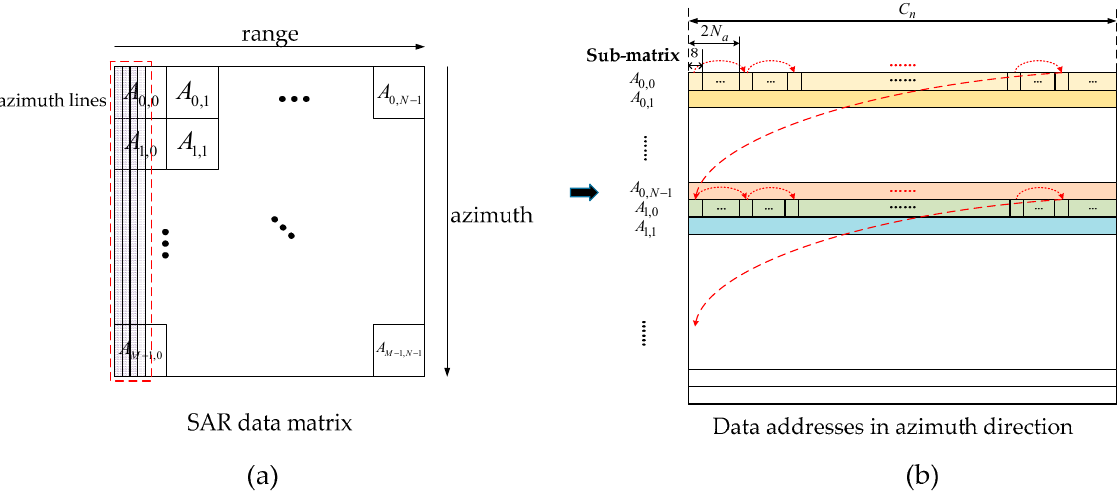
Figure 11. Data access address change method in azimuth direction. ( a ) The four azimuth lines to be accessed in the SAR data matrix; ( b ) the physical addresses of the four azimuth lines to be accessed in DDR3 (each cell represents eight burst transmission data in DDR3; the red dotted line represents the data access sequence in DDR3).